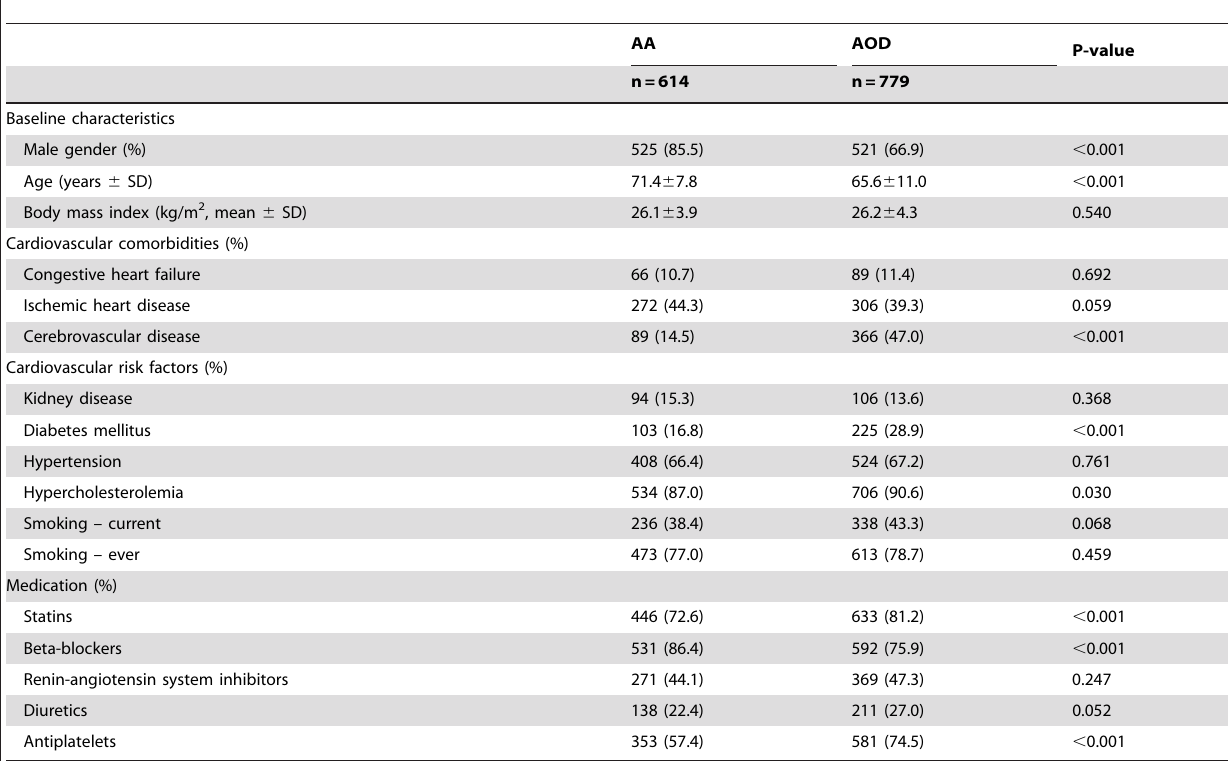
Table 1. Clinical characteristics of patients with aortic aneurysm (AA) or arterial occlusive disease